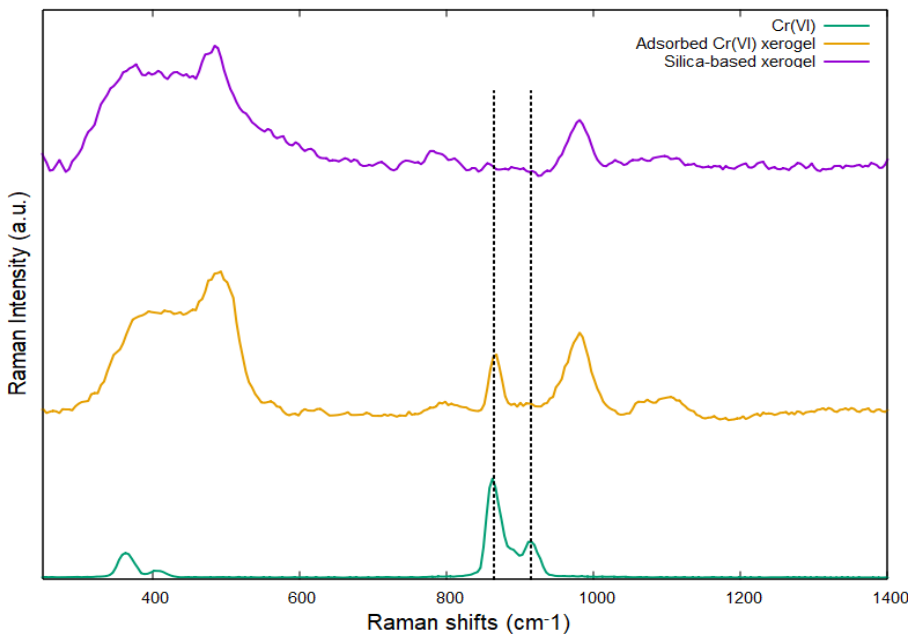
Figure 10. Raman spectra of silica-based xerogel before (purple) and after Cr(VI) absorption (yellow) and K 2 CrO 4 powder (green).